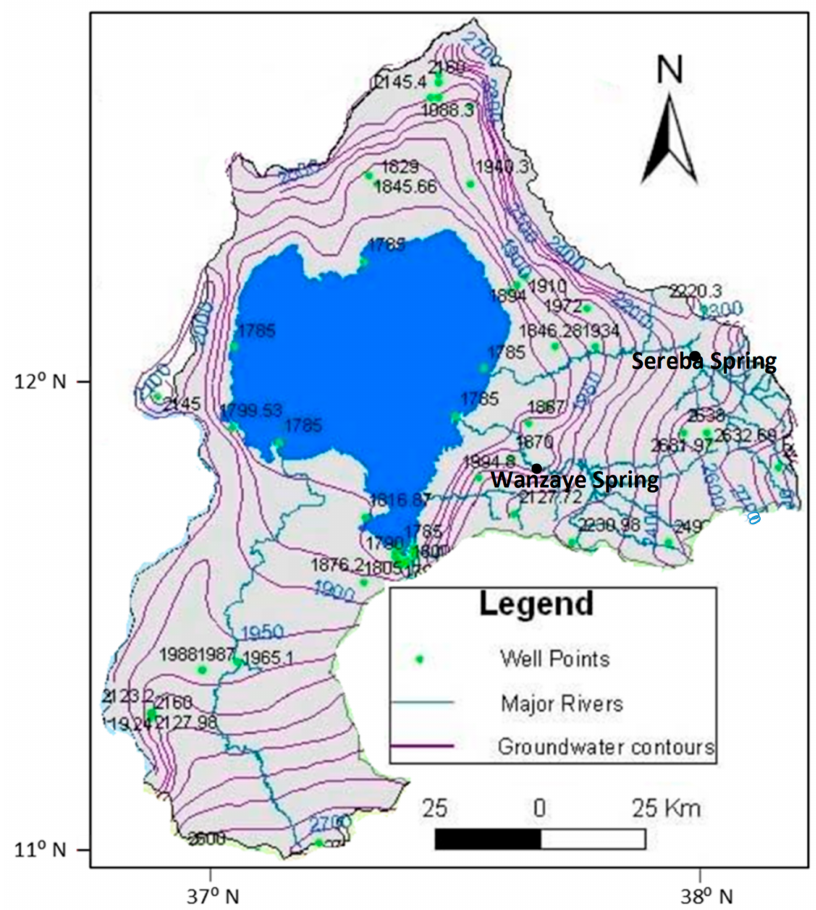
Figure 7. Groundwater head distribution in the Lake Tana Basin modified after Kebede et al. [63,64]. The hydraulic head values of the well points and some the contour are shown. The contour interval is 100 m. They are concentrated on the highlands and relatively far apart in the plain part, showing the high gradient in the highland, and the low in the